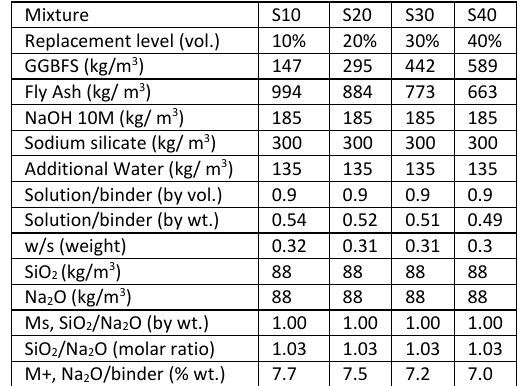
Table 2. Mixture proportions for Series